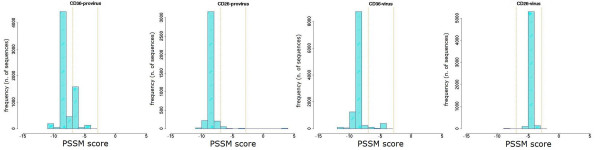
PSSM score distribution of V3 amino acid sequences from Pt.5. The PSSM score distribution of all variants from CD36- and CD26-provirus detected in Pt.5 at the moment of therapy interruption are shown together with those from CD36- and CD26-captured virus present one month after therapy stop. Vertical orange lines indicate percentiles for predicted co-receptor usage as in Fig. 6.